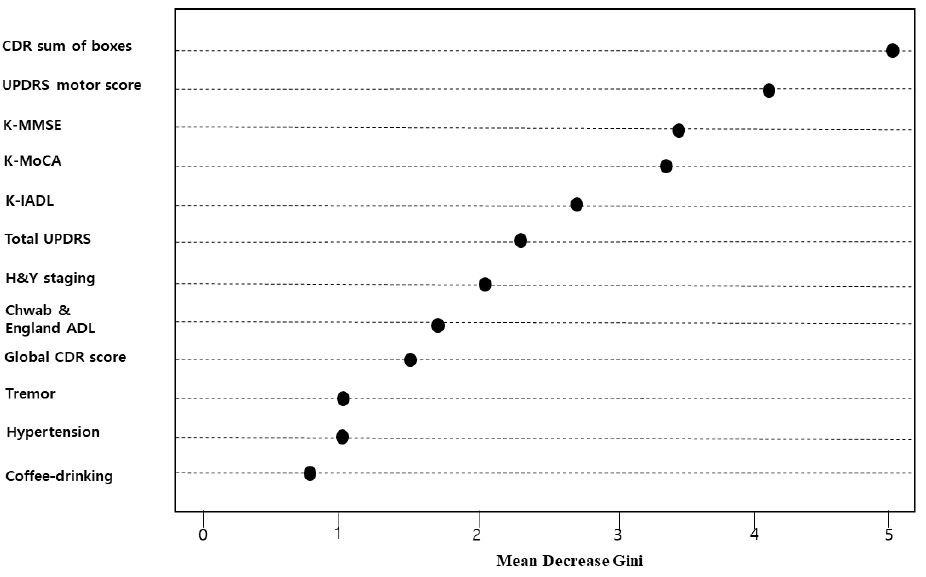
Figure 3. Variable importance in a random forest model (showing only the top 12 factors).